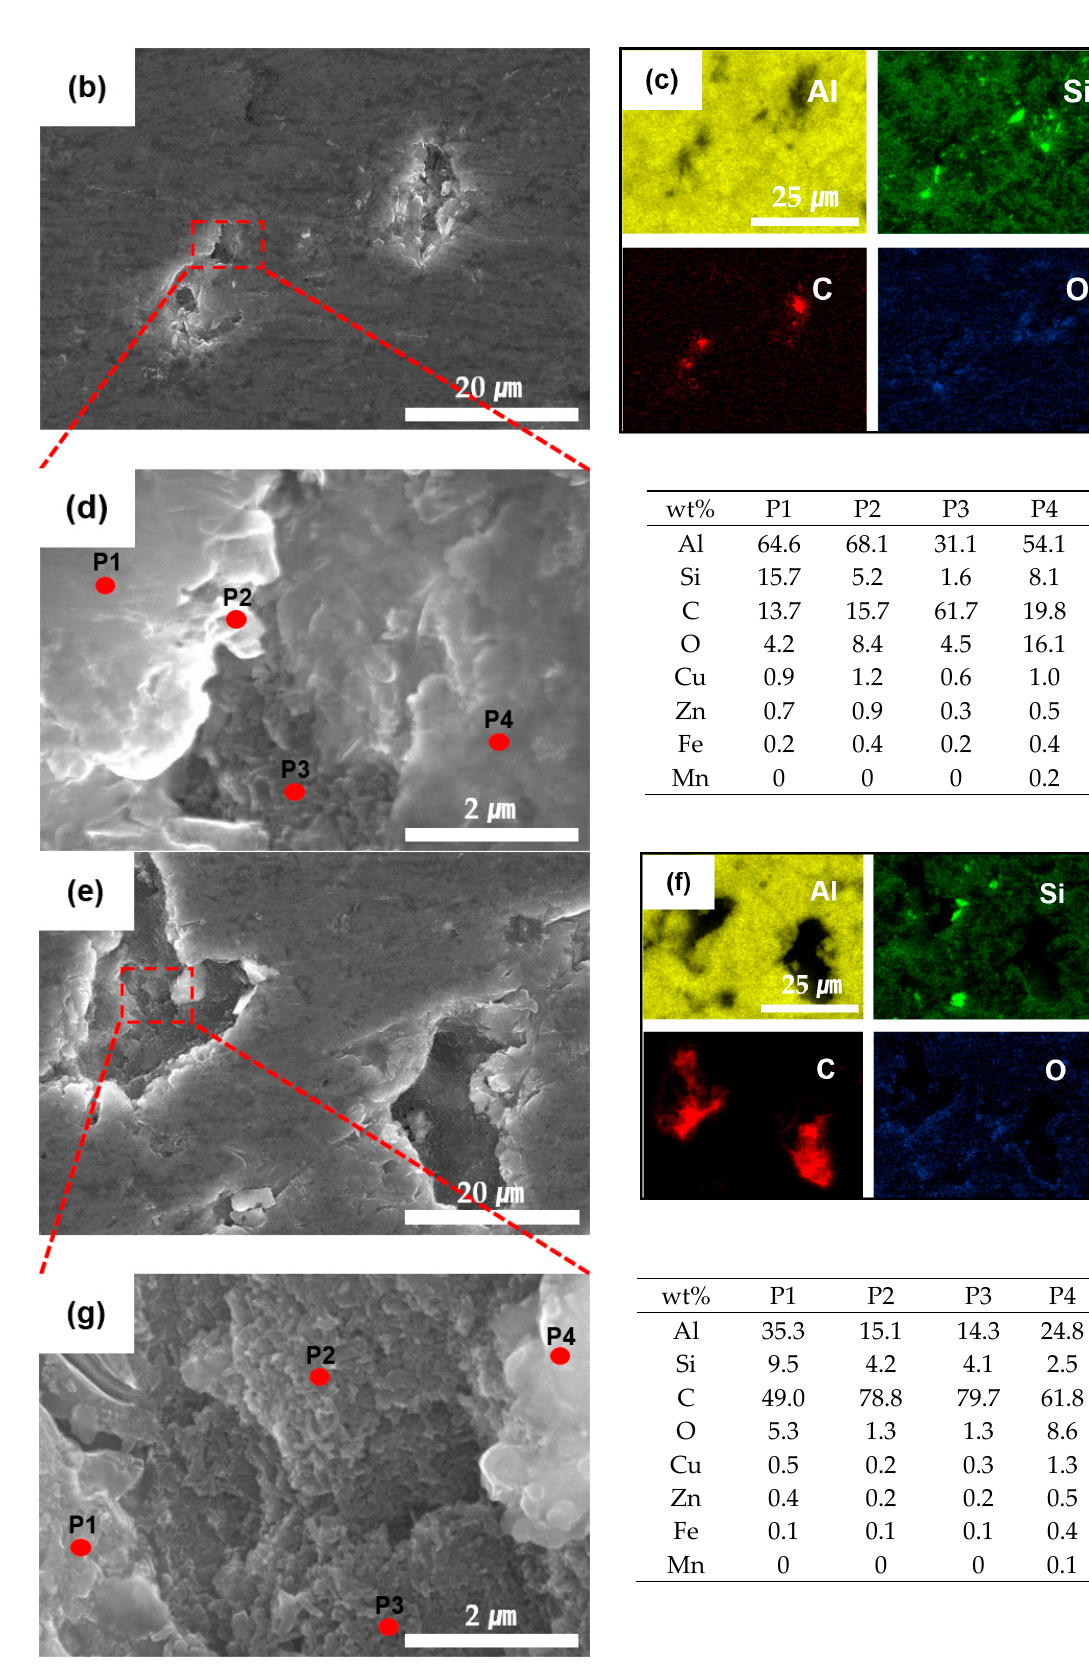
Figure 7. ( a ) TEM and ( b – d ) SEM images of 1.0 wt% CNT-added composite and ( e – g ) SEM images of 2.0 wt% CNT-added composites cast using a poly gate by using ORDC.